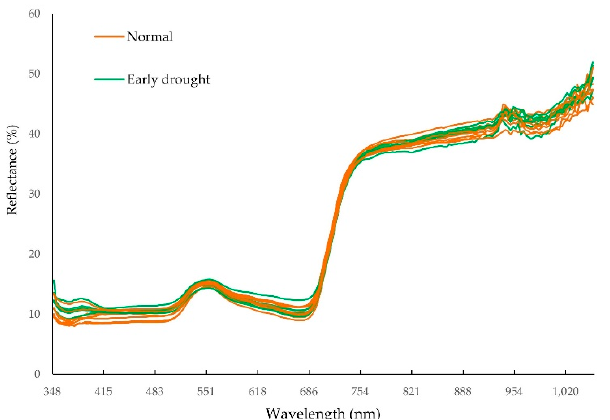
Figure 6. NIR spectra of “normal physiological status” (brown line) and “early physiological drought status” (green line) for the tomato variety “Rosada”.